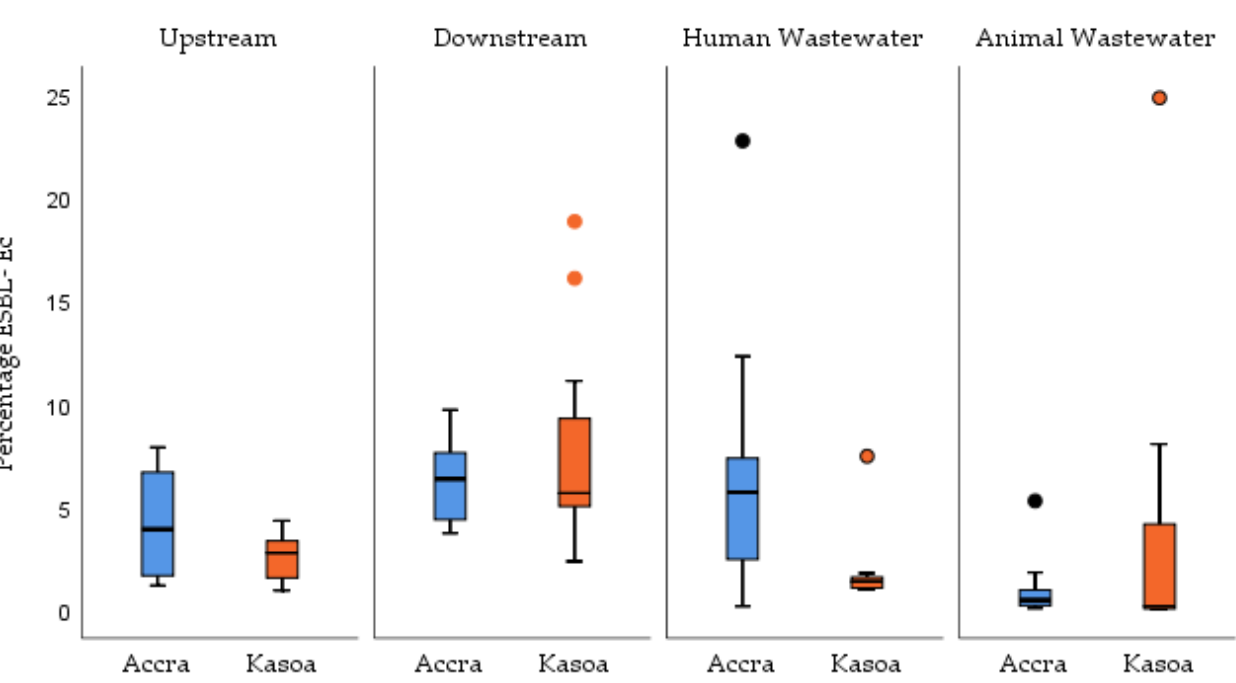
Figure 5. Comparison of percent ESBL-Ec in Accra and Kasoa or the periods of August 2018–December 2019, October